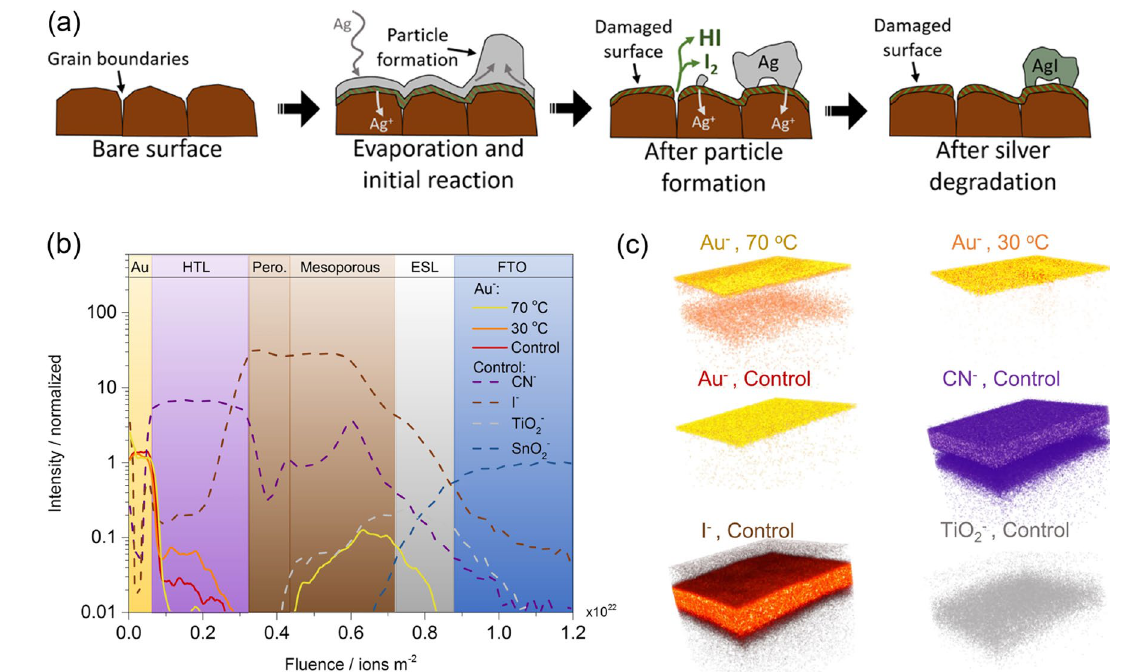
Fig. 7 a Degradation model of evaporated Ag with perovskite. Reproduced with permission from Ref. [151]. Copyright 2020, American Chem- ical Society. https:// pubs. acs. org/ doi/ 10. 1021/ acsami. 9b203 15, please note that further permission related to the material excerpted should be directed to the ACS. b Time of flight secondary ion mass spectroscopy elemental depth profiles of the control device and aged devices at 30 and 70 °C. c Reconstructed elemental 3D maps for the ions traced in the depth profile. b , c Reproduced with permission from Ref. [154]. Copyright 2016, American Chemical